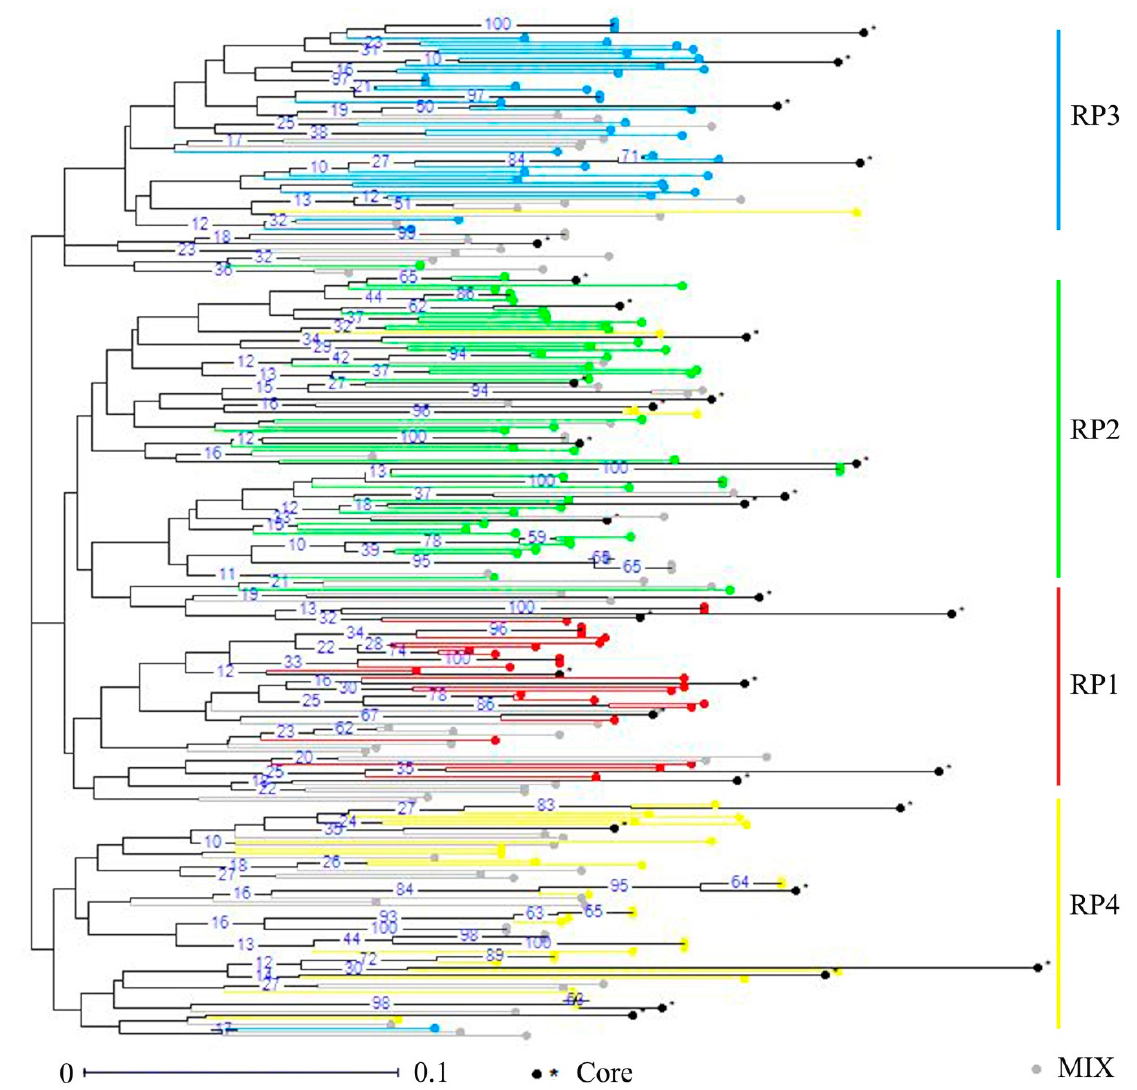
Figure 4. Distribution of the core collection in the NJ tree of the whole database based on genetic dissimilarity.